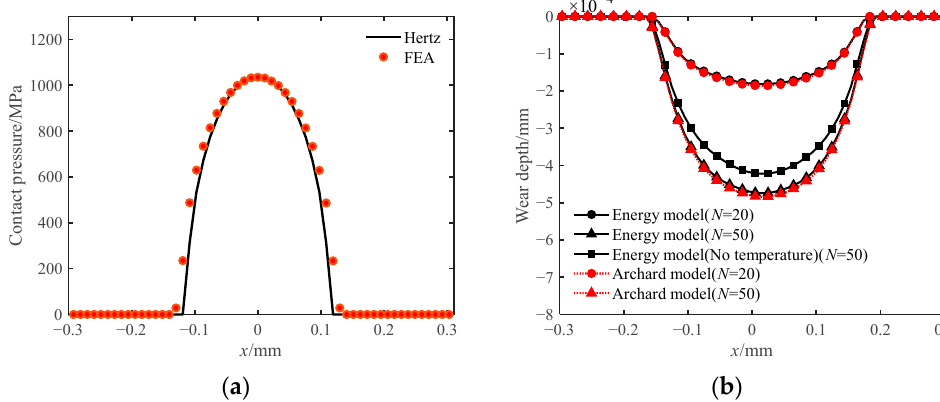
Figure 5. Verification of finite element model. ( a ) Comparison of contact pressure; ( b ) comparison of wear depths.